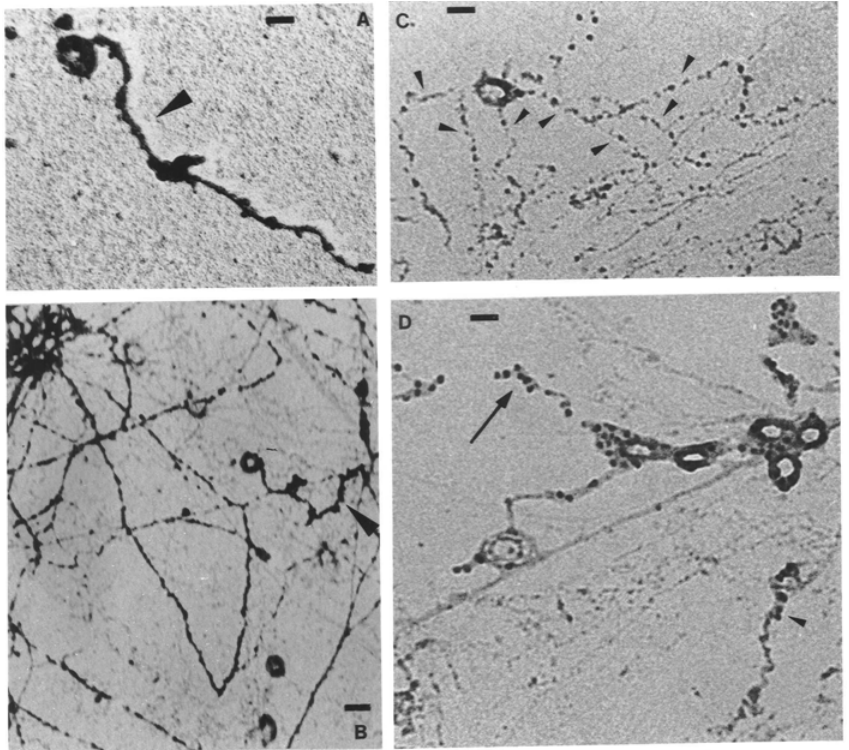
Fig. 2 – Pore-linkedfilaments are shown in normal (A, C and D) and DNase treatment (B) assays. The filaments are tortuous and heterogeneous in width (arrowheads in A and B). Six or more filaments can be observed attached to a same NPC (arrowheads in C). RNP particles appear aligned along filaments probably remnants of NL or of intranuclear filaments (arrow and arrowhead, respectively in D). A and B (4n, spread of whole cells; alcoholic uranyl acetate). C and D (2n; spread of isolated nuclei; aqueous uranyl acetate). Bars = 92 nm (A), 140 nm (B), 100 nm (C) and 90 nm